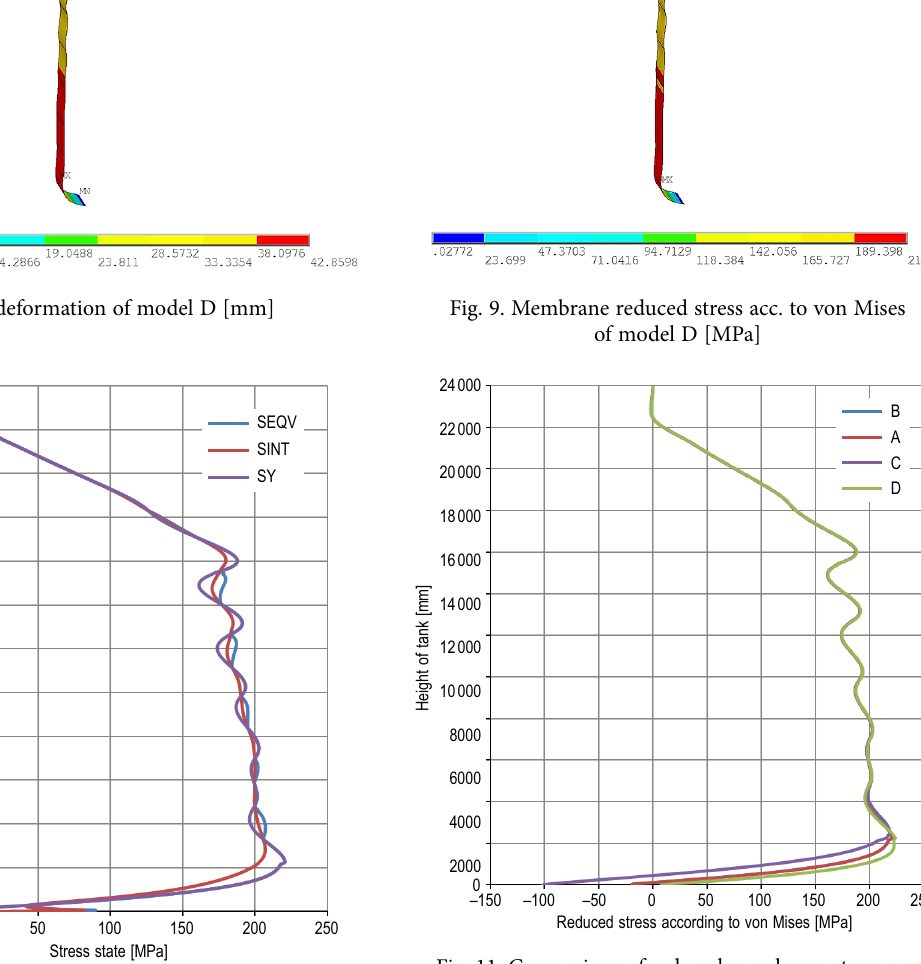
Fig. 10. Membrane stress distribution of model A